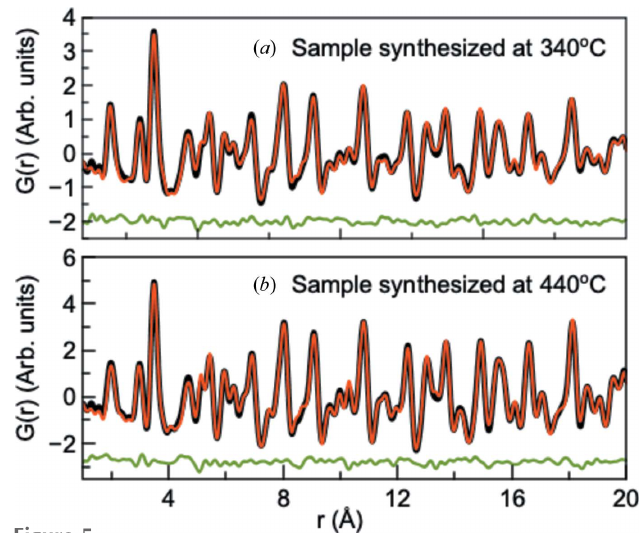
Figure 5 Experimental PDFs (black), PDFs calculated from fitted models (red) and difference curves (blue) for the spinel iron oxide nanoparticles synthesized at ( a ) 340 and ( b ) 440 (cid:4) C. Fits including the 1–60 A˚ range can be found in Fig.